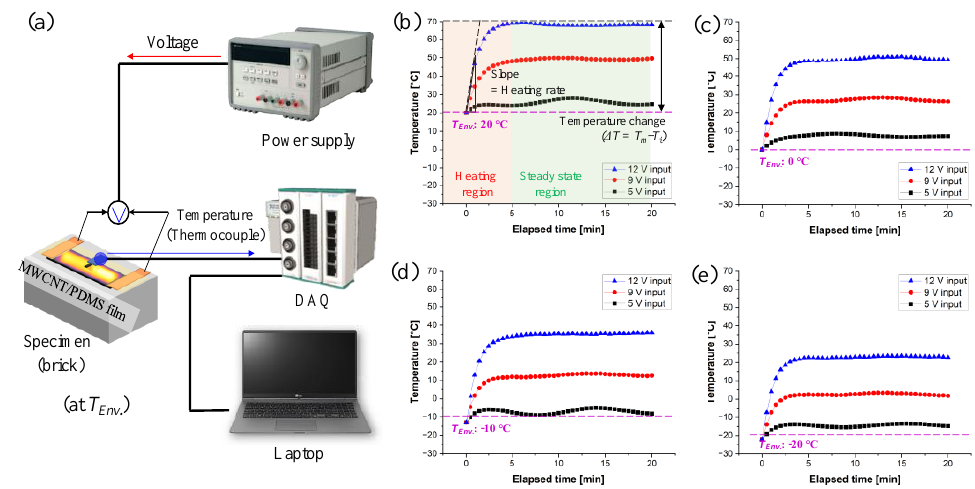
Figure 6. ( a ) Electric-heating setup and performances of MWCNT/PDMS composite depending on applied voltage (5, 9, and 12 V) and in ( b ) 20, ( c ) 0, ( d ) − 10, and ( e ) − 20 ◦ C of environmental temperature ( T Env ).